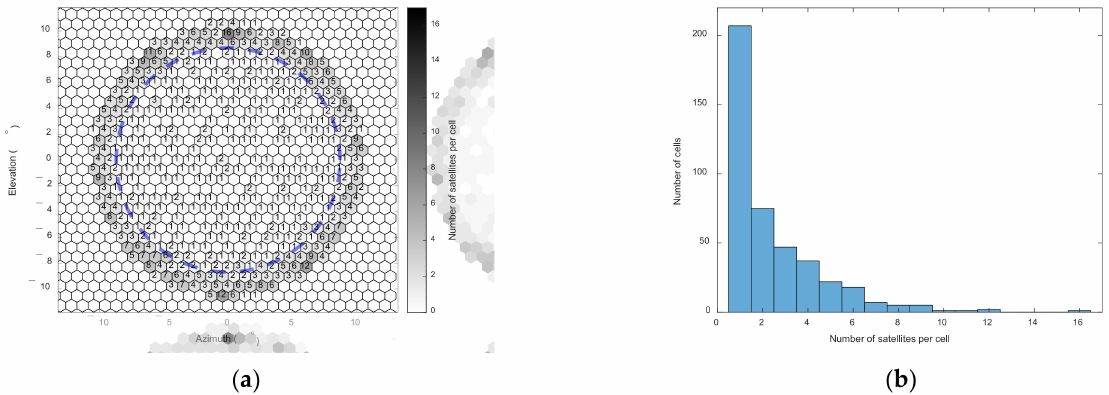
Figure 4. Characteristics of the object distribution in FOV of GEO data relay satellite with 1 ◦ spot beams: ( a ) LEO satellite occupation of spot beams. The number in the center of each cell indicates the transient LEO satellites in the coverage of a certain beam. The blue dash line sketches the contour of Earth’s surface; ( b ) statistics of the cell